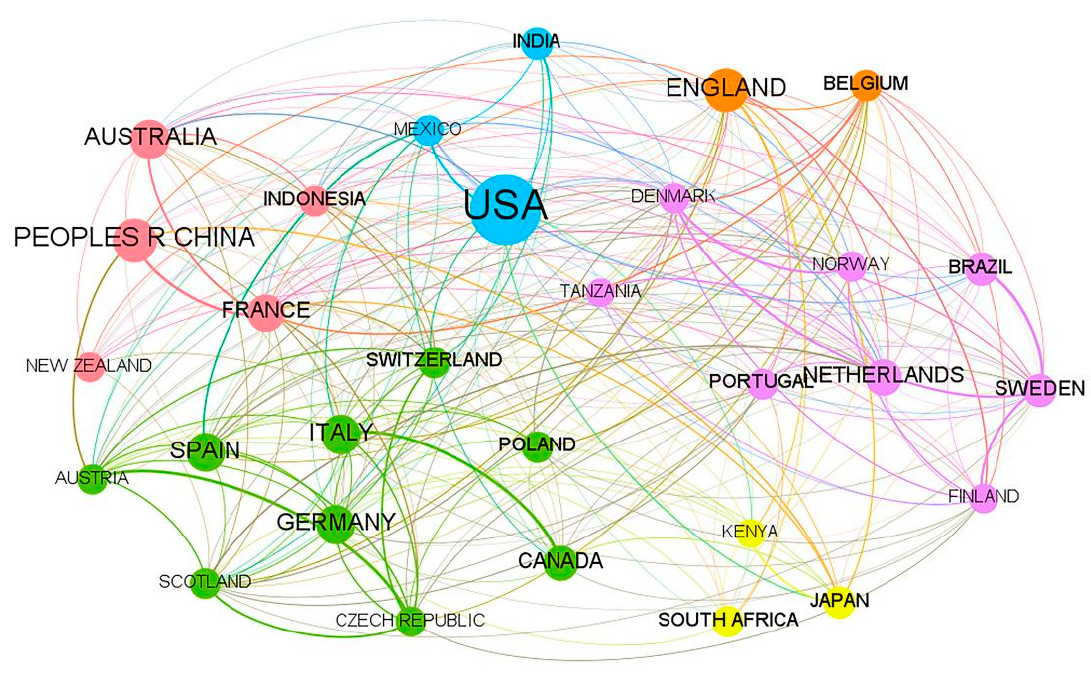
Figure 5. Principal cooperation network of productive countries (regions) from 1990 to 2021. Table 5. Top 10 productive countries or regions during the period from 1990 to 2021.